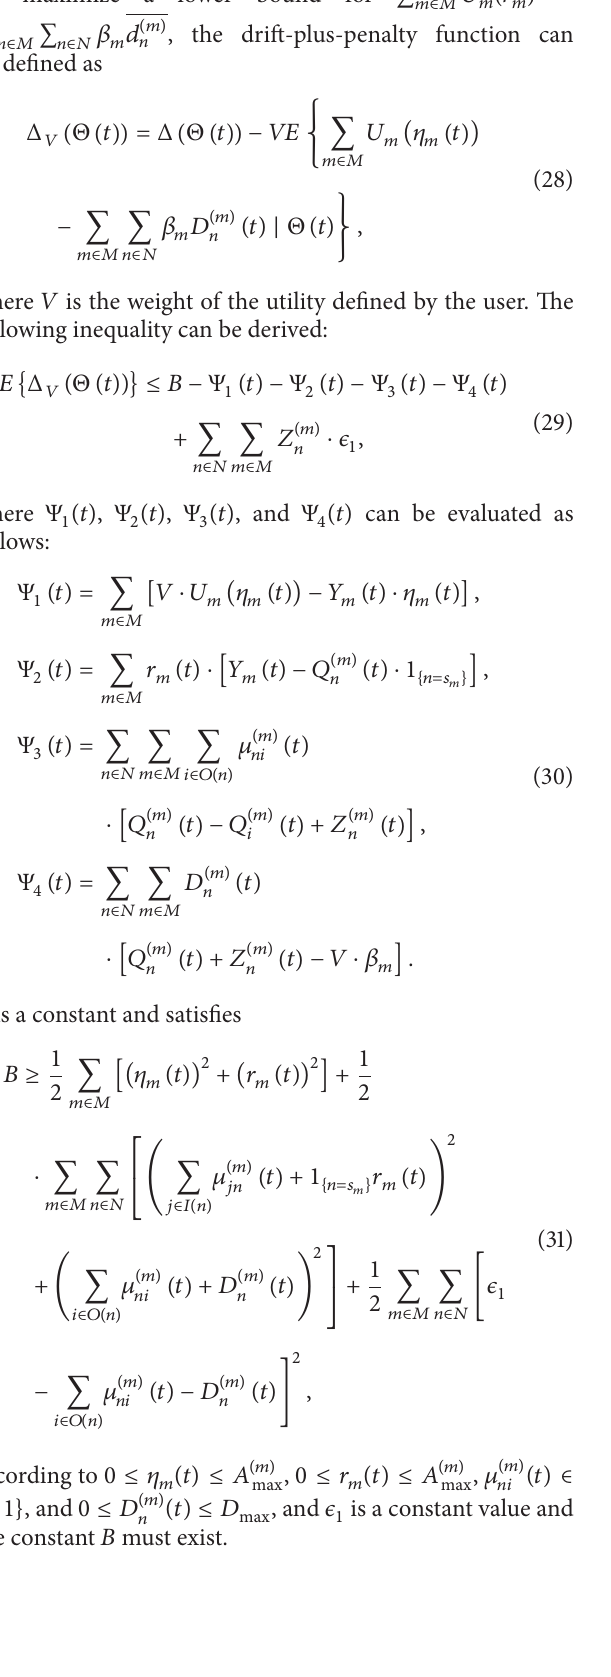
The algorithm CCWD is based on the drift-plus-penalty framework [17] and the main design principle of the algo- rithm is to minimize the right-hand side of (29). The algorithm includes two